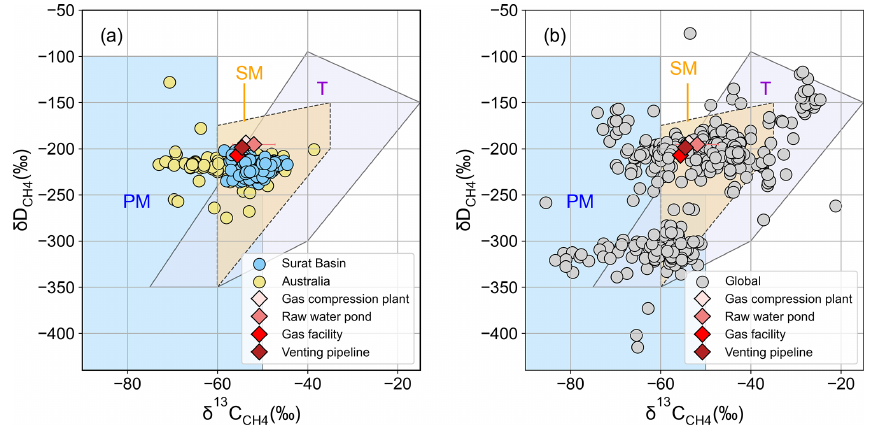
Figure 4. A comparison of δ 13 C CH and δ D CH of CSG from this study versus values from the Surat Basin, Australia-wide (a) and worldwide 4 4 (b) . All values are taken from Sherwood et al. (2017) and literature sources listed in Table 1. The gas genetic fields are taken from Milkov and Etiope (2018). PM: primary microbial; SM: secondary microbial; T: